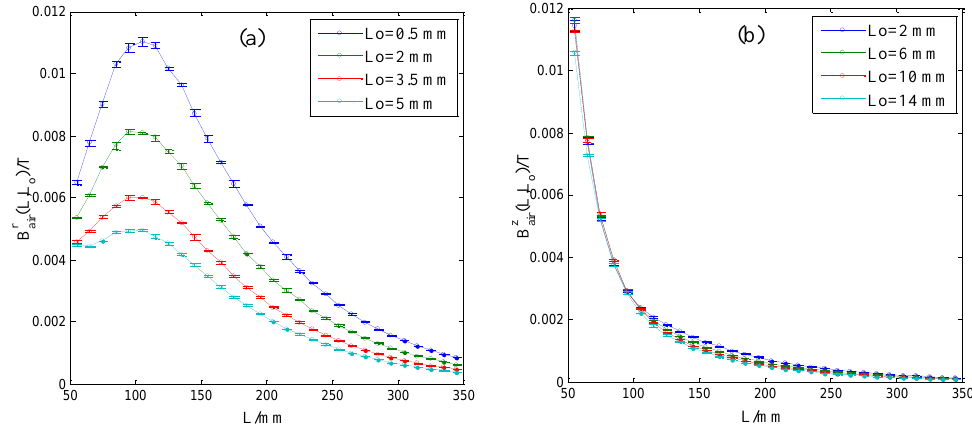
Figure 11. Three repeated measurements of radial ( a ) and axial ( b ) magnetic flux densities at different lift-offs in the measurement region.